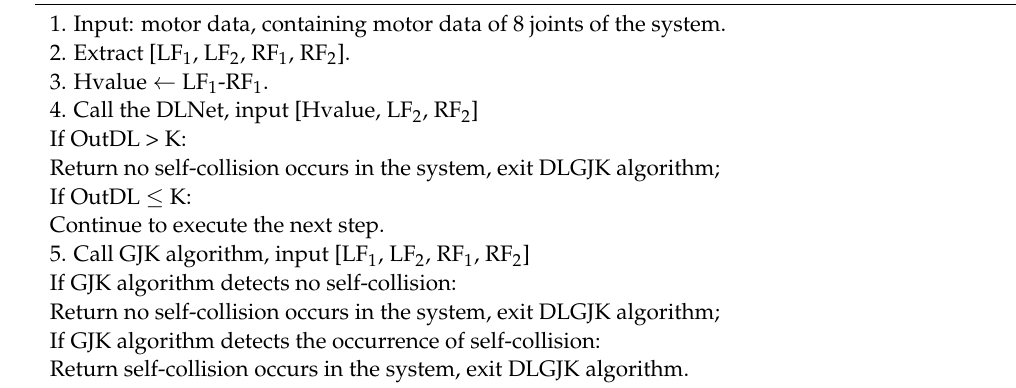
Algorithm 1 DLGJK self-collision detection of the LF-RF dual-manipulator system